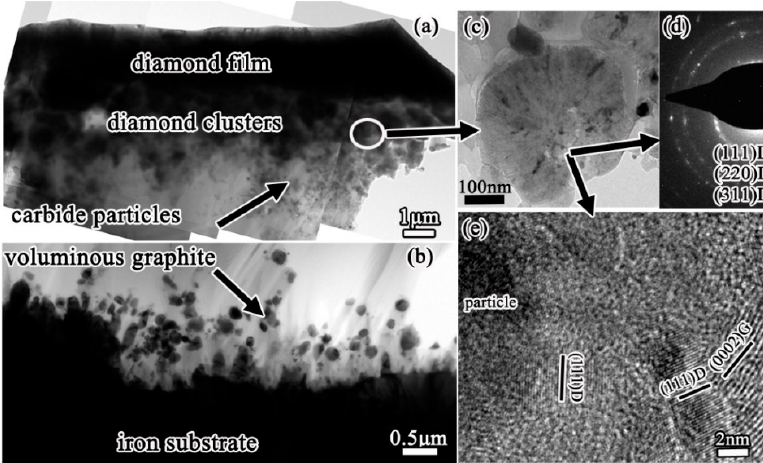
Figure 9. Cross-sectional TEM images of ( a ) the delaminated diamond film peeled off and ( b ) the residual graphite interlayer on iron substrate. Some clusters are observed in the transitional zone: ( c ) enlarged-TEM image, ( d ) corresponding selected-area electron diffraction (SAED) pattern, and ( e ) HRTEM image of the cluster. (Reproduced with permission from [98]).